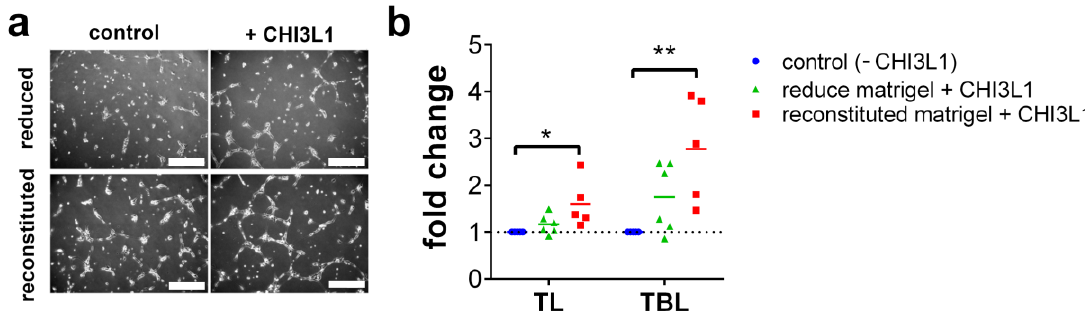
Figure 7. CHI3L1 liberated proangiogenic factors from matrigels promoted tube formation by HUVEC. ( a ) Representative images of HUVEC seeded on growth factor reduced or FCS reconstituted matrigel. HUVEC were either treated with PBS (control) or 400 ng/mL CHI3L1. ( b ) Automatized analysis of the total tube length (TL) and the total branching length (TBL). Data were normalized to the corresponding control experiment. n = 5; * p ≤ 0.05, ** p ≤ 0.01 one-way ANOVA.